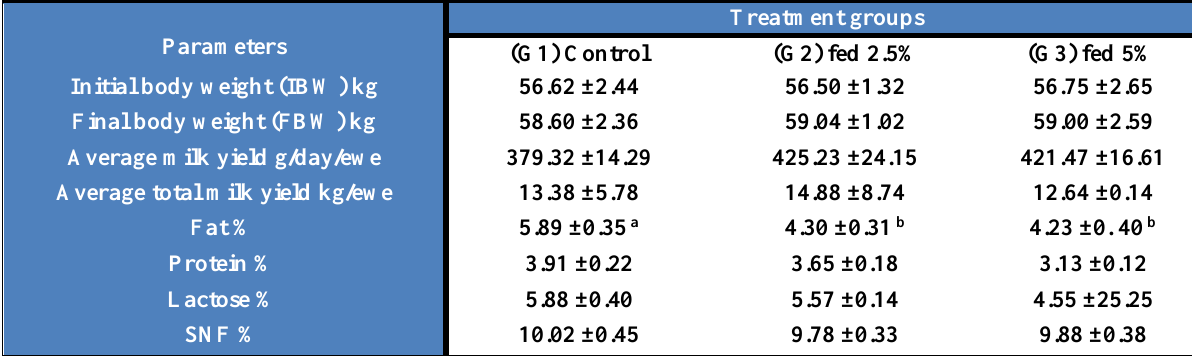
Table, 2: Effect of adding sunflower oil in the diet on the mean of ewes weights, milk yield and main composition (mean ± SE)